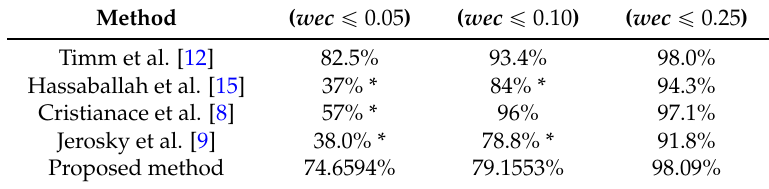
Table 1. Iris center localization accuracies compared to the state-of-the-art methods.